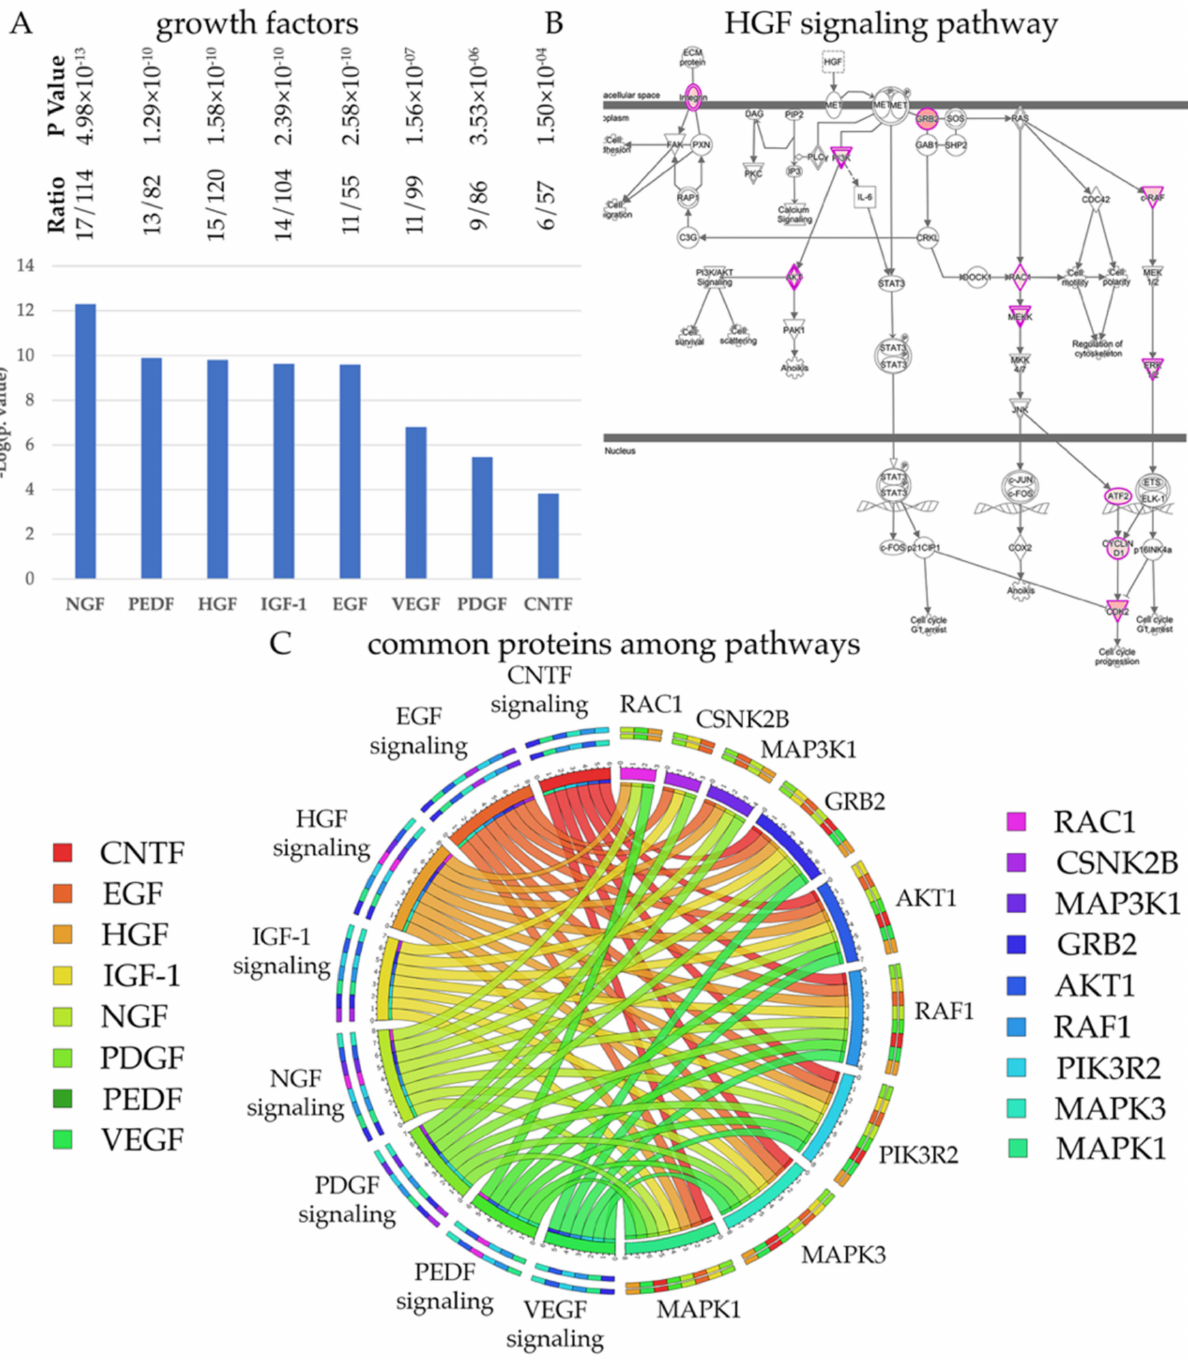
Figure 4. UMNs require a distinct set of growth factors. ( A ) Bar graphs of canonical pathways involved in growth factor mediated signaling. ( B ) Image of HGF signaling pathway, representing the extent of HSP/PLS protein involvement. Proteins with higher binding partners are marked with increasing color intensity. ( C ) Circular representation of HSP/PLS proteins that are commonly present among different canonical